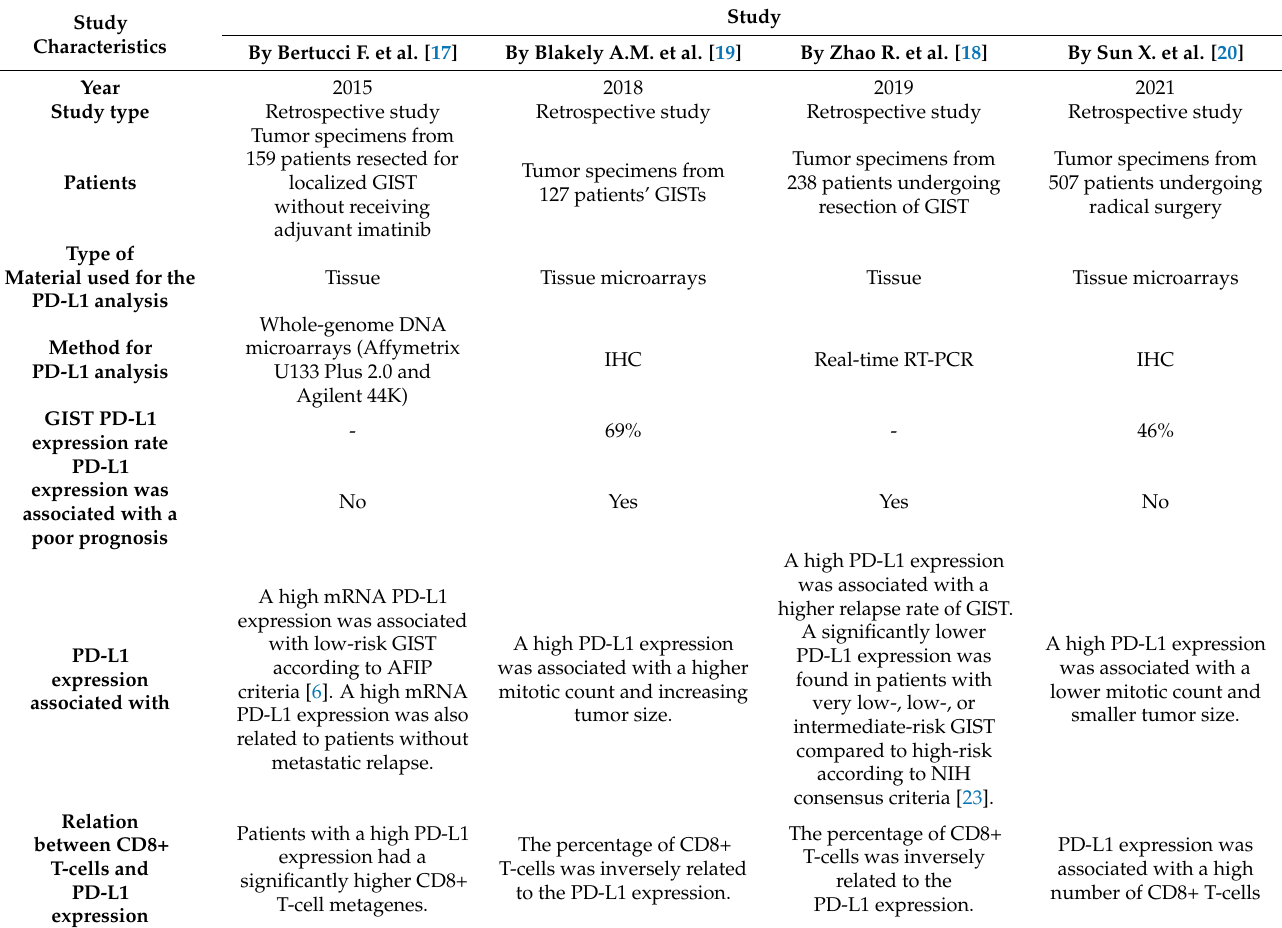
Table 6. Studies investigating PD-L1 expression in Gastrointestinal Stromal Tumor (GIST)